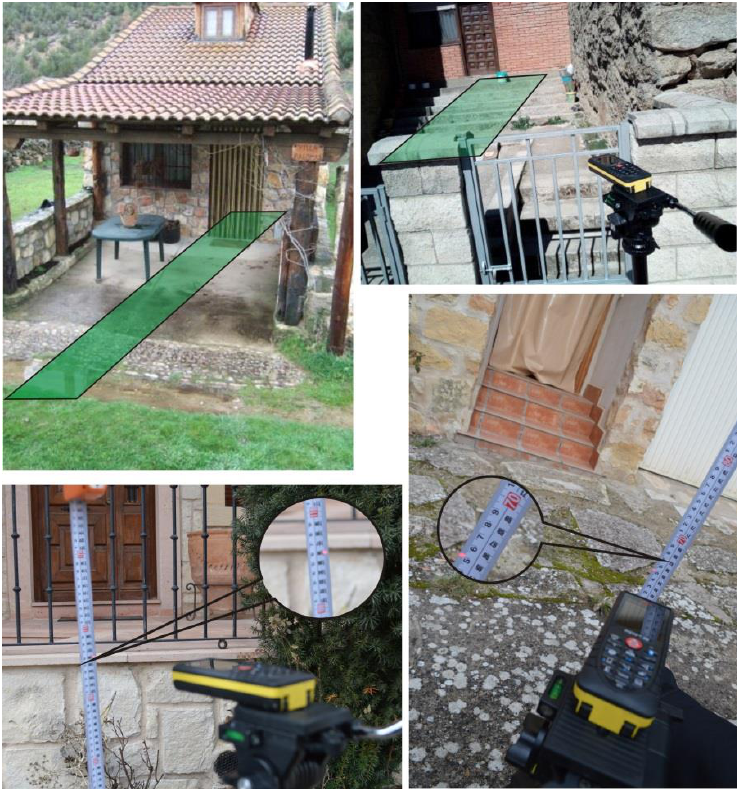
Figure 2. Examples of houses with topographic over– and under–elevation with respect to the surrounding land.